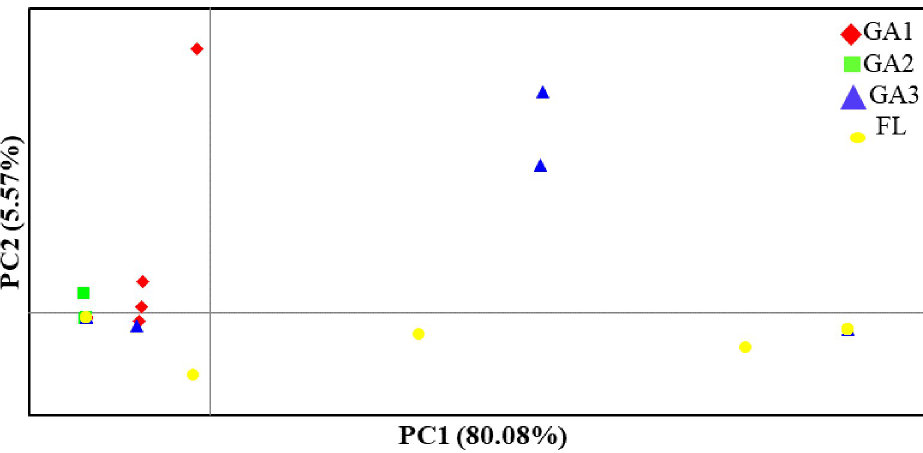
Fig 1. Principal coordinate analysis of four populations of Fusarium oxysporum f. sp. niveum isolates collected from watermelon fields in southeastern United States. Sampling locations include Berrien County, Georgia (GA1), Cook County, Georgia (GA2), Tift County, Georgia (GA3), and Florida (FL). PC1 (80.08%) and PC2 (5.57%) refer to the first and the second